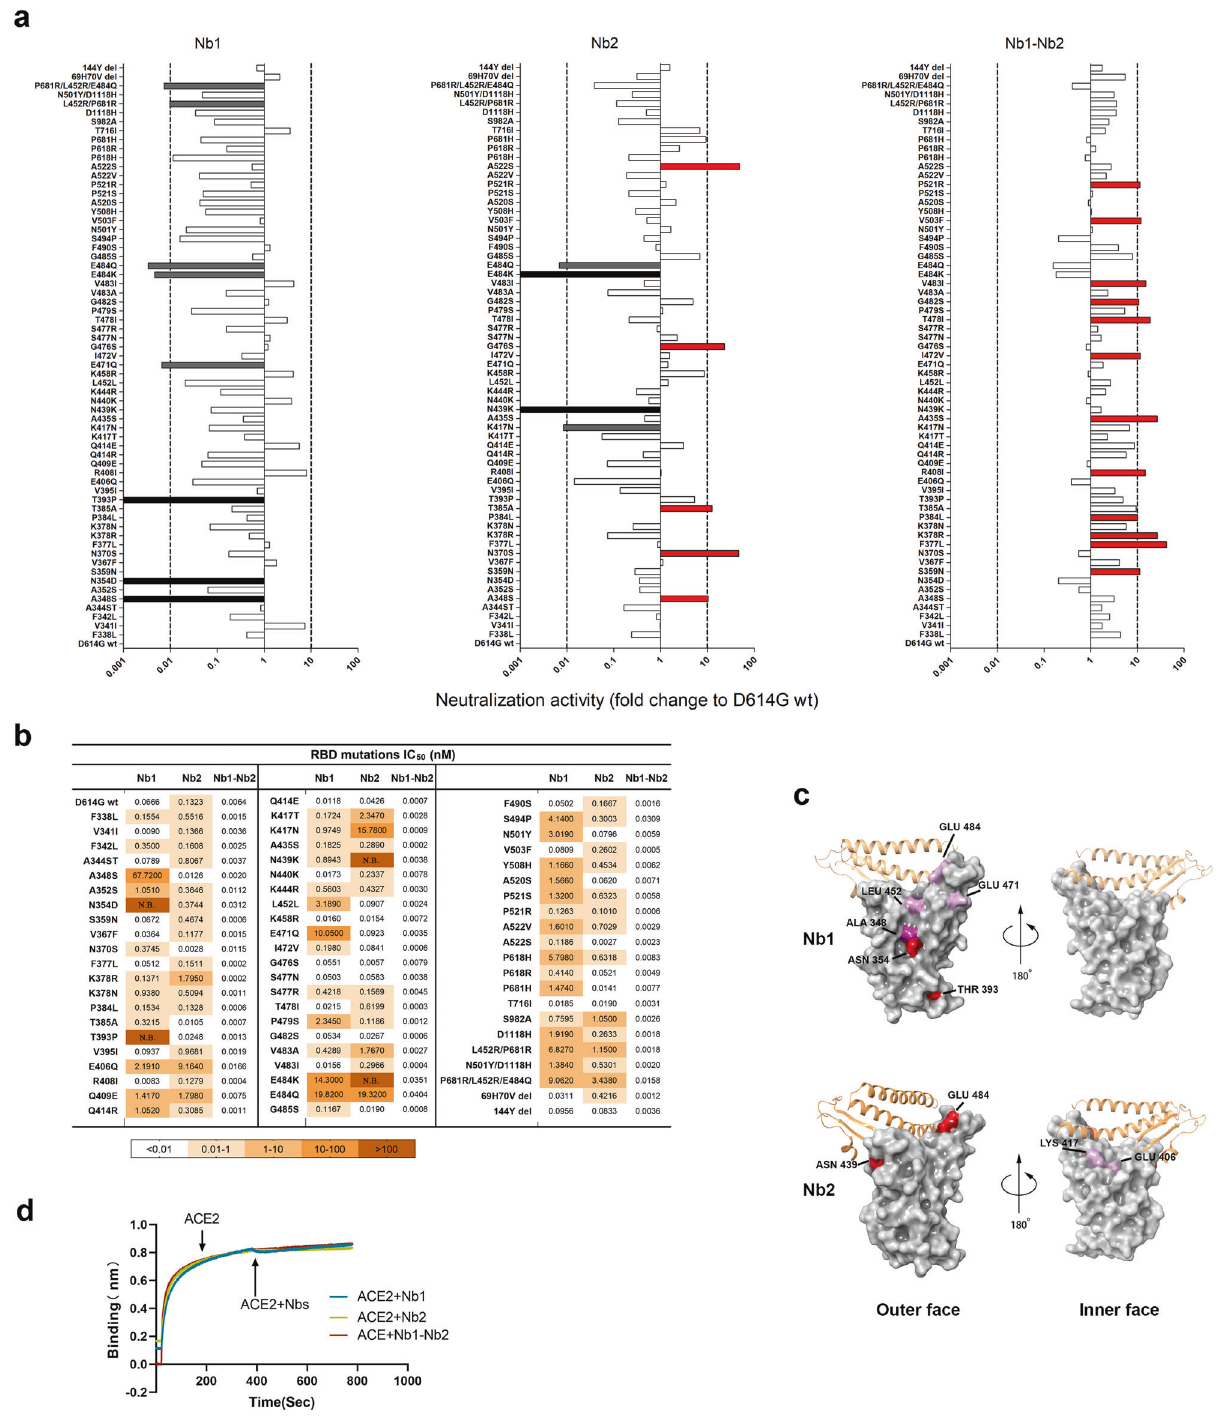
Fig. 3 Epitope mapping using naturally occurring Spike mutants. a The SARS-CoV-2 pseudoviruses were packaged using more than 60 Spike variants identi fi ed from circulating viral sequences. The majority of mutations occur on RBD, including single amino acid substitution, combinational mutation and deletion. Neutralization activity conferred by Nb1, Nb2, and bivalent Nb1 – Nb2 was evaluated. The x axis shows the ratio of IC 50 of D614G pseudovirus/IC 50 of indicated pseudovirus variant. When the ratio is greater than 1, the neutralization activity is increased, otherwise, the activity is decreased. The y axis shows the names of mutations. Data are represented as mean. All experiments were repeated at least twice. b IC 50 values of indicated Nbs against SARS-CoV-2 mutation pseudovirus were calculated from data in ( a ). c Location of critical amino acids on the RBD (PDB ID: 6M0J) region for Nb1 and Nb2. The key hot spots targeted by Nbs are shown in a color-coding pattern with resistant strength descending from red to pink. Both sides of RBD are shown from different angles. d Competition between Nbs and ACE2 for binding to the SARS-CoV-2 RBD. Octet sensors immobilized with the SARS-CoV-2 RBD were fi rst saturated with ACE2 protein and then exposed to the Nb1, Nb2, or Nb1 – Nb2. The experiments were independently performed twice, and similar results were obtained